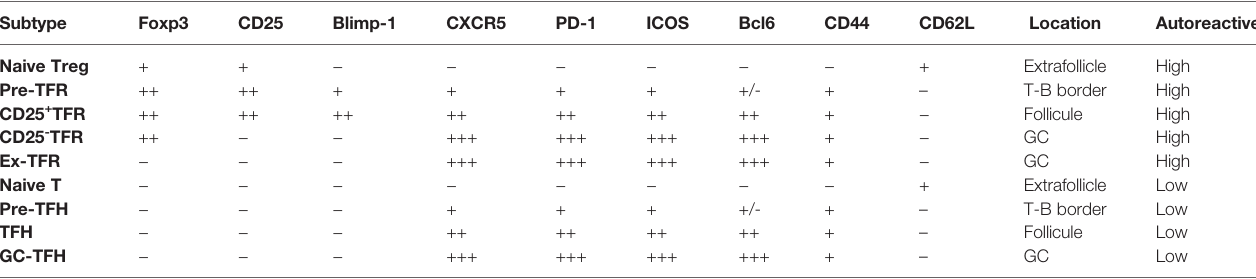
TABLE 1 | The markers for the identi fi cation of TFR and TFH.